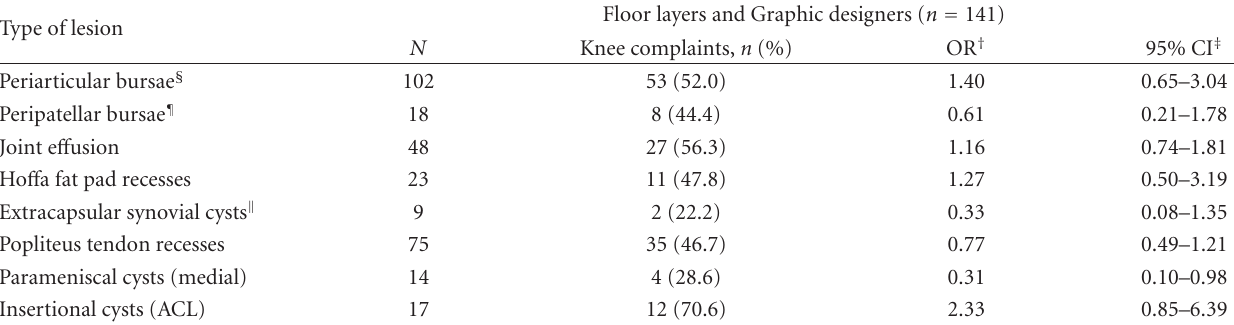
Table 4: Association between knee complaints ∗ and cyst-like